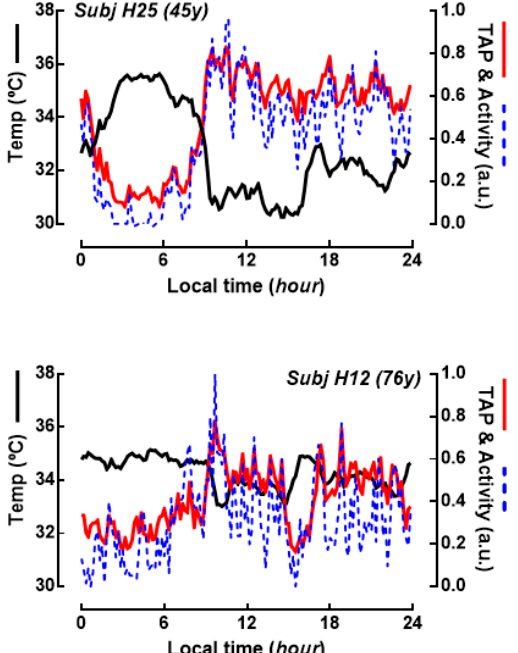
Figure 1. Circadian marker rhythms in human subjects. Traces represent the averaged values of skin wrist temperature and activity recorded ambulatorily during one week. The variable TAP (red line) is calculated from normalized records of temperature, activity and position (also recorded but not shown in this figure), and serves as a functional index of the circadian system in normal living conditions, oscillating from 0 (sleep, no activity) to 1 (wakeful, high activity). TAP and activity are shown as normalized records (arbitrary units) and temperature as raw data (°C). Top graph shows data from a 45 years old subject, and bottom graph from a 76 years old subject.